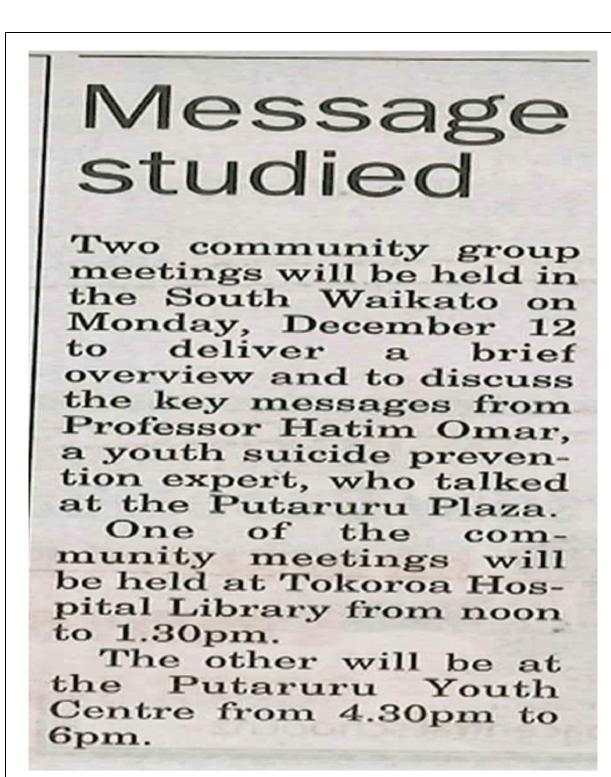
FIGURE 4 | Local media announcement about suicide prevention groups